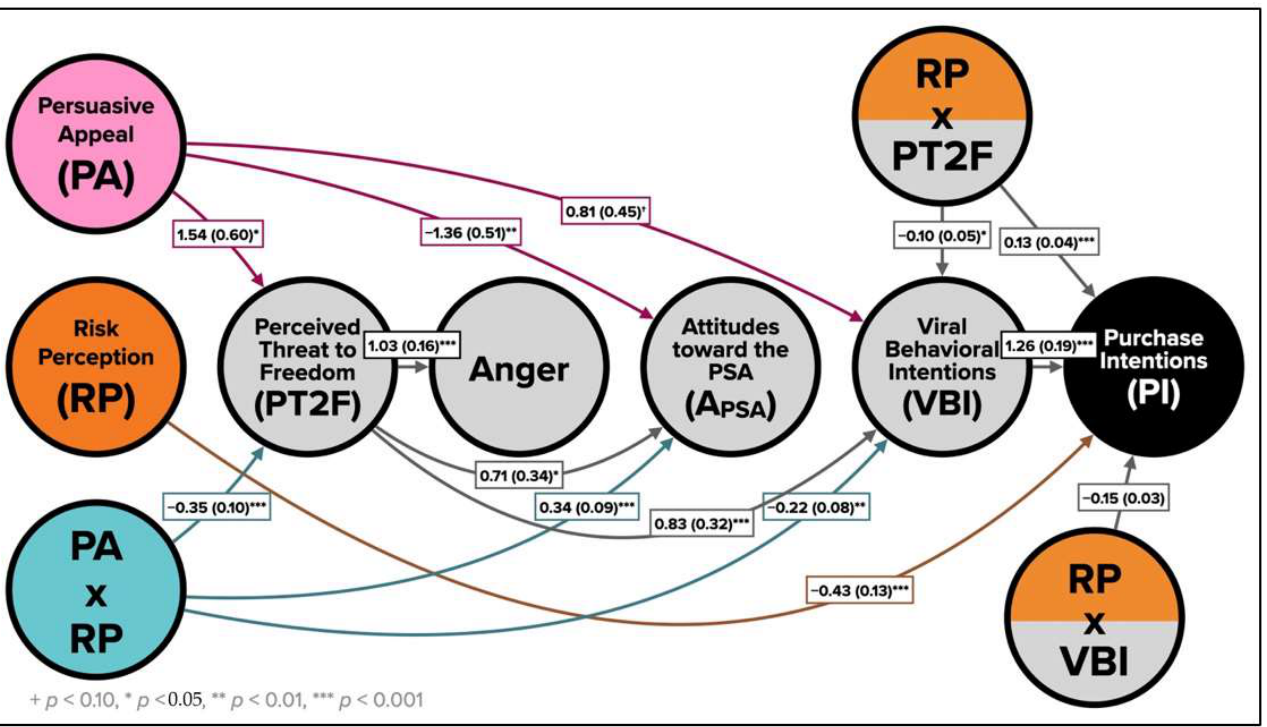
Figure 5. Moderated serial mediation of the effect of persuasive appeal on PI, moderated by risk perceptions.